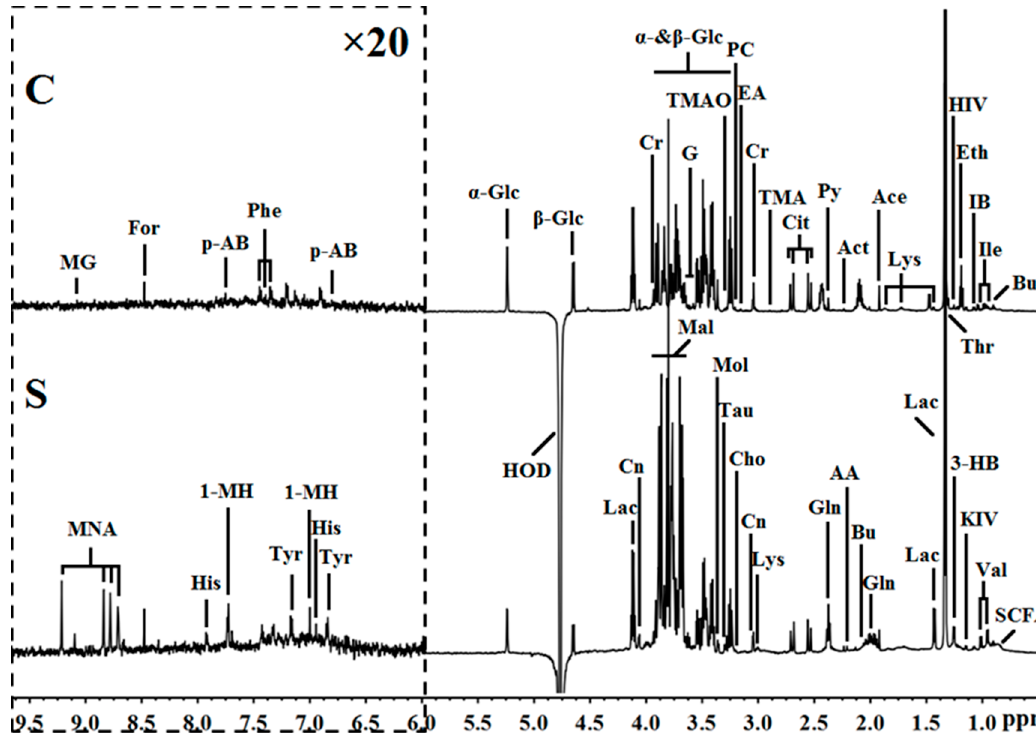
Figure 2. Typical 1 H NMR spectra ( δ 0.5-9.0) of A549 cell extracts obtained from groups treated with ( S ) and without ( C ) rFIP-nha. The region of δ 6.0–9.5 (in the dashed box) was magnified 20 times compared with the corresponding region of δ 0.5–6.0 for clarity. Keys: 1-MH, 1-methylhistideine; 3-